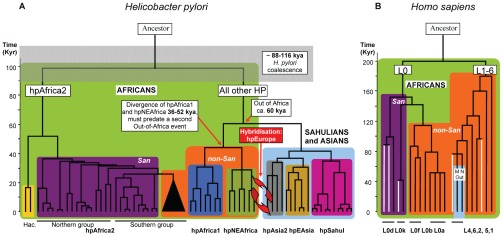
A comparison of global H. pylori and human mtDNA phylogenies.(A) Global phylogeny of H. pylori displayed as the strict consensus of 100 ClonalFrame analyses. After outgroup-rooting with H. cetorum, the time of the basal H. pylori divergence between hpAfrica2 and all other populations was estimated to 102 kya (95% confidence limit, 88–116 kya). Divergence of the other African H. pylori populations, hpAfrica1 and hpNEAfrica, began between 36 and 52 kya. (B) Simplified human mtDNA phylogeny adapted from Behar et al., 2008 [14] with the permission of AJHG. African lineages are shown on a green background whereas the background for lineages outside Africa is light blue. San clades are purple, non-San clades are orange and H. acinonychis is yellow. San mtDNA lineages in our sample are shown as white lines.